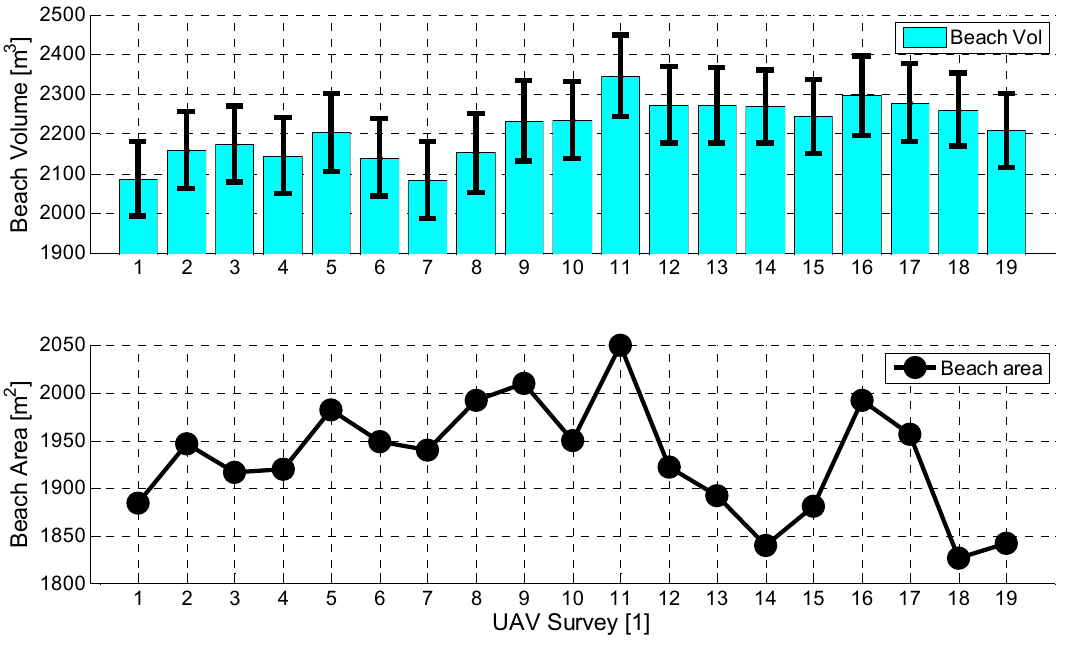
Figure 12. Beach volumes ( top ) and beach areas ( bottom ) during surveying.